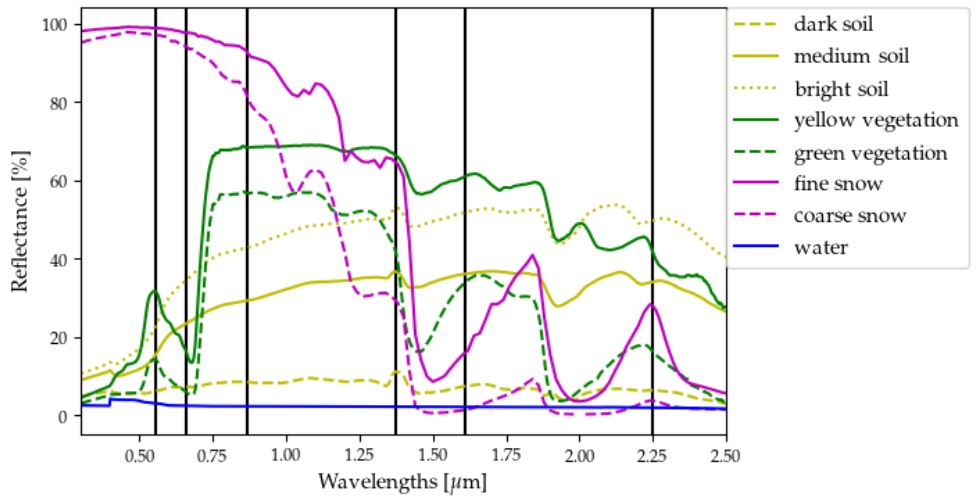
Figure 4. Representative spectral reflectance of snow, clouds, soil, and vegetation in the visible and infrared